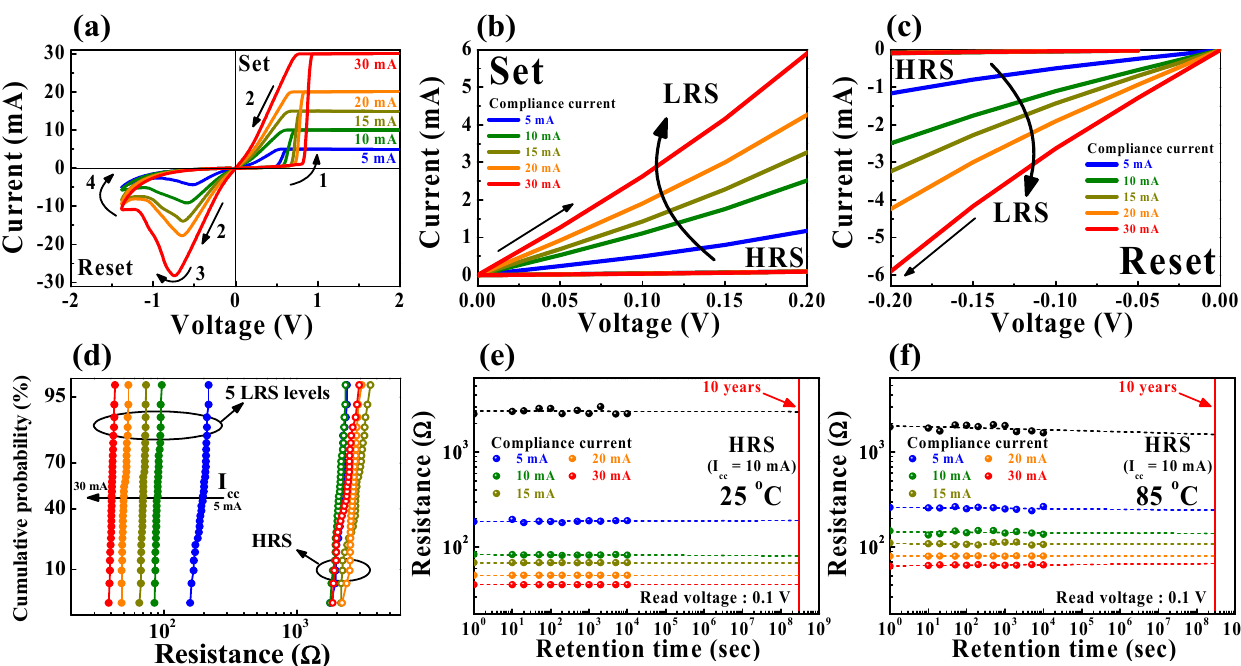
Figure 3. Multilevel per cell (MLC) characteristics of SPE-chitosan memristors. ( a ) Multilevel BRS I - V curves obtained by adjusting the set compliance current ( I cc ) value from 5 to 30 mA. ( b , c ) The enlarged positive- and negative-voltage regions of the BRS I - V curves, respectively. ( d ) Cumulative probabilities of five different LRS and HRS levels during repetitive cycling. Nonvolatile retention performance of six different resistance states during 10 4 s at ( e ) room temperature (25 °C) and (f) a high temperature (85 °C).